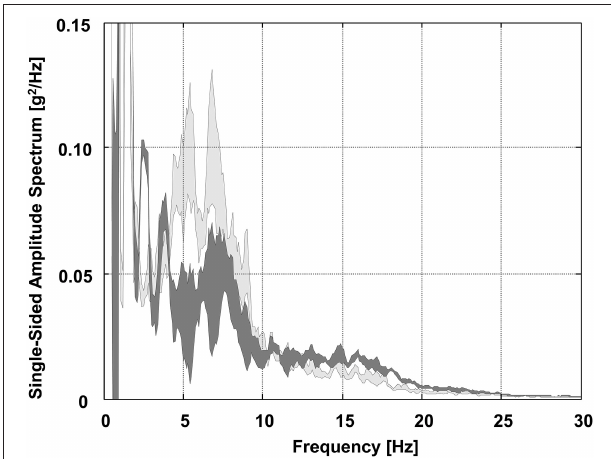
FIGURE 5 | Areas of uncertainty around the estimate of the mean ( ± SE) of the lower back (i.e., sacrum sensor) group average power spectral density (PSD) curves for frequencies below 30 Hz in GS and SL. Light gray, GS; dark gray, SL.